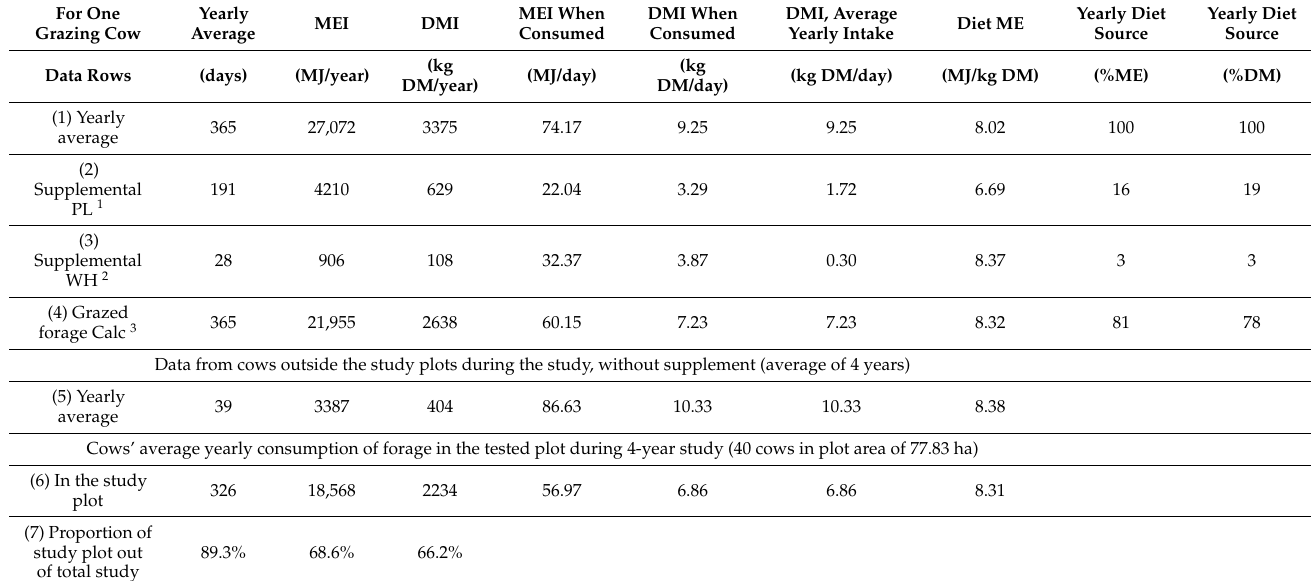
Table 3. Calculated average annual consumed diet energy (ME), dry matter intake (DMI) and metab- olizable energy intake (MEI) from the grazing sources and from the supplemented feed